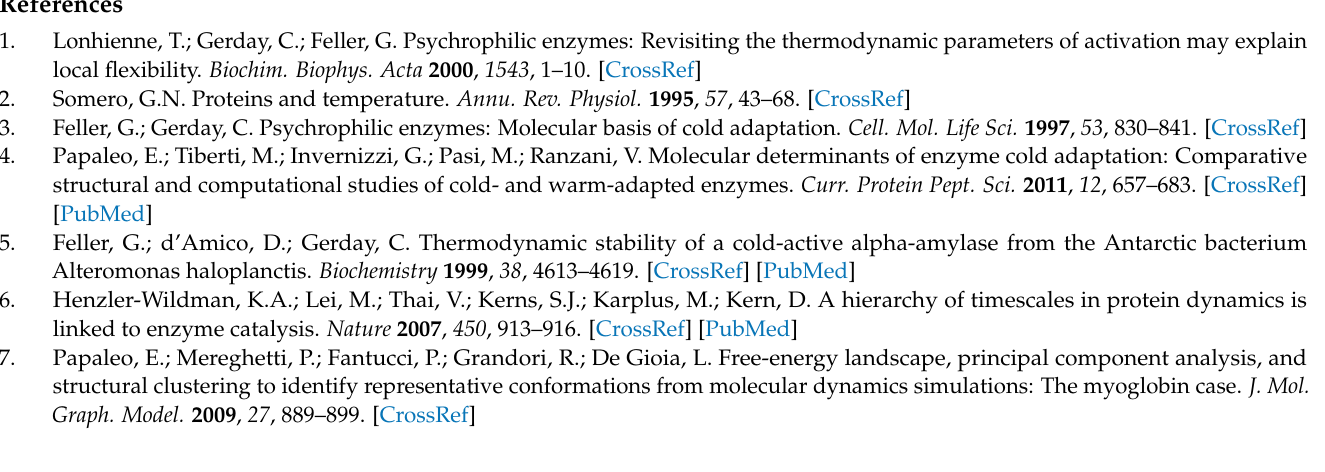
Table S1: Standard deviations (SDs) of the RMSD means and cosine contents (CCs) of the first two eigenvectors (Eig.1 and Eig.2) calculated based on the 10-100 ns trajectories of the 10 independent MD simulation replicas and the single joined equilibrium trajectories (only for